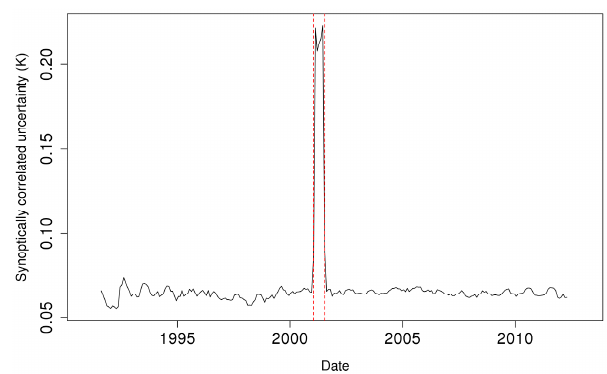
Figure 7. Monthly mean synoptically-correlated uncertainty estimate from the L2P data calculated across all available drifting buoy match-ups (black line). Also shown are the change points identified in 2001 (vertical red dashed lines).